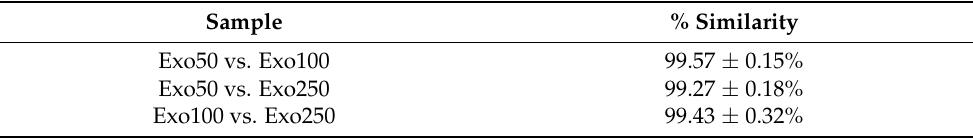
Table 1. Summary of the FTIR Quick Compare analysis of the exosomes.